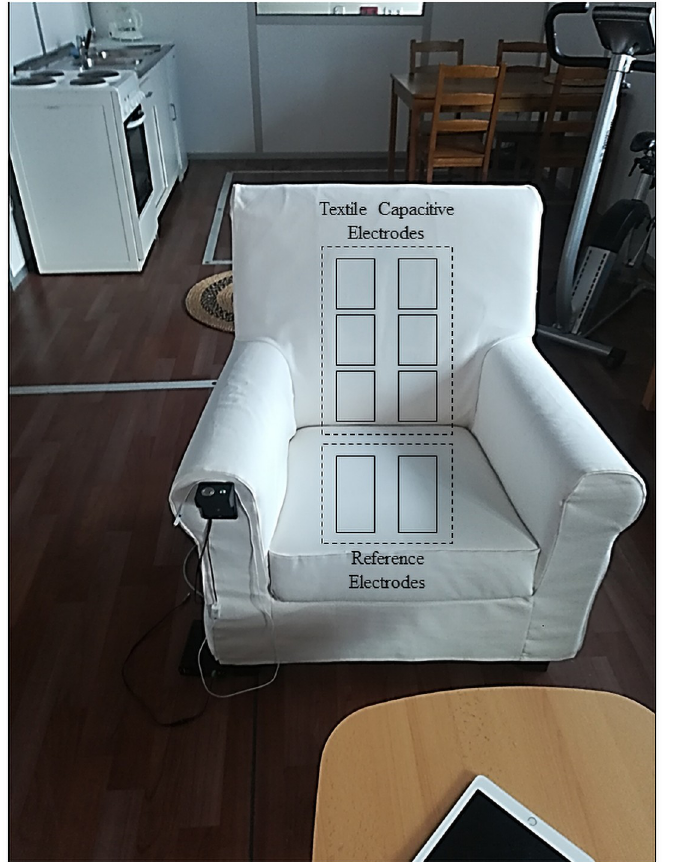
Fig 1. cECG armchair with capacitive